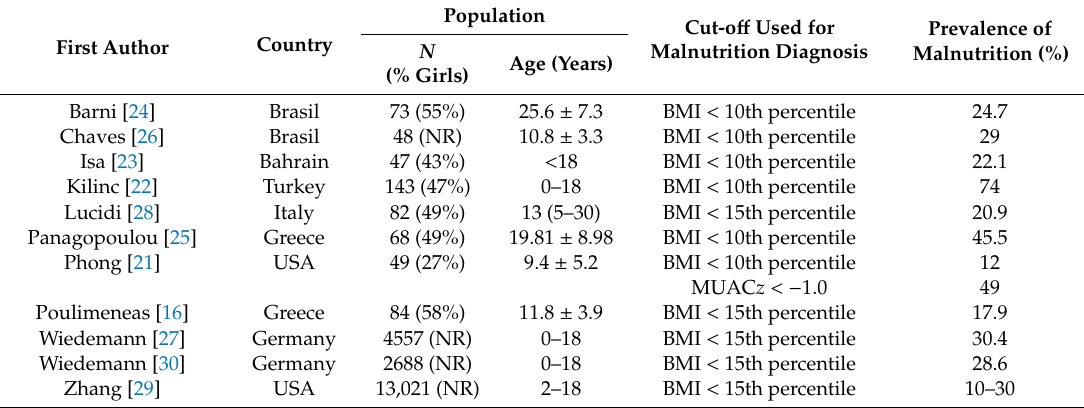
Table 3. The existing literature on the prevalence of malnutrition among children and adolescents with